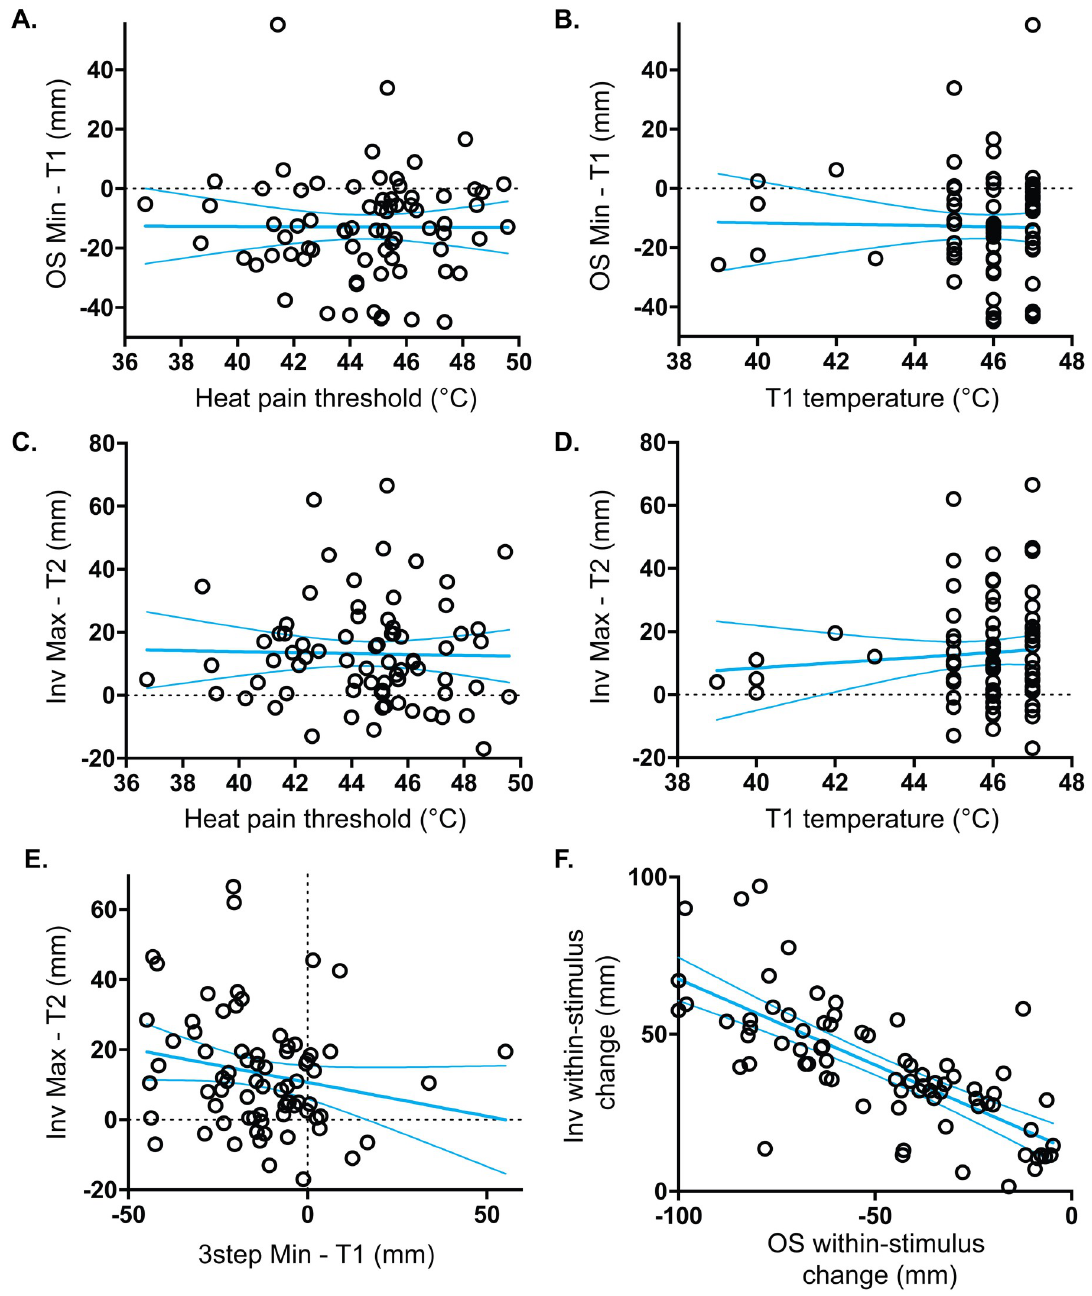
Fig 8. Pain intensity amplification with either increases or decreases are independent of temperature but are correlated with each other. Scatter plots are shown with each point representing an individual subject. Heavy cyan lines represent best-fit lines from linear regression analysis with thin cyan lines representing bounds of the 95% confidence intervals calculated as part of the linear regression. No correlation exists between stimulus intensity (heat pain threshold (A or C) or T1 stimulus temperature used (B or D)) and pain intensity modulation during the t3 period by either preceding noxious temperature decreases (OS Min-T1) or increases (Inv Max-T2). Although an inverse correlation between onset hyperalgesia and offset analgesia does not achieve statistical significance when comparing local extrema (E), a significant inverse correlation is detected using within-stimulus change (F).